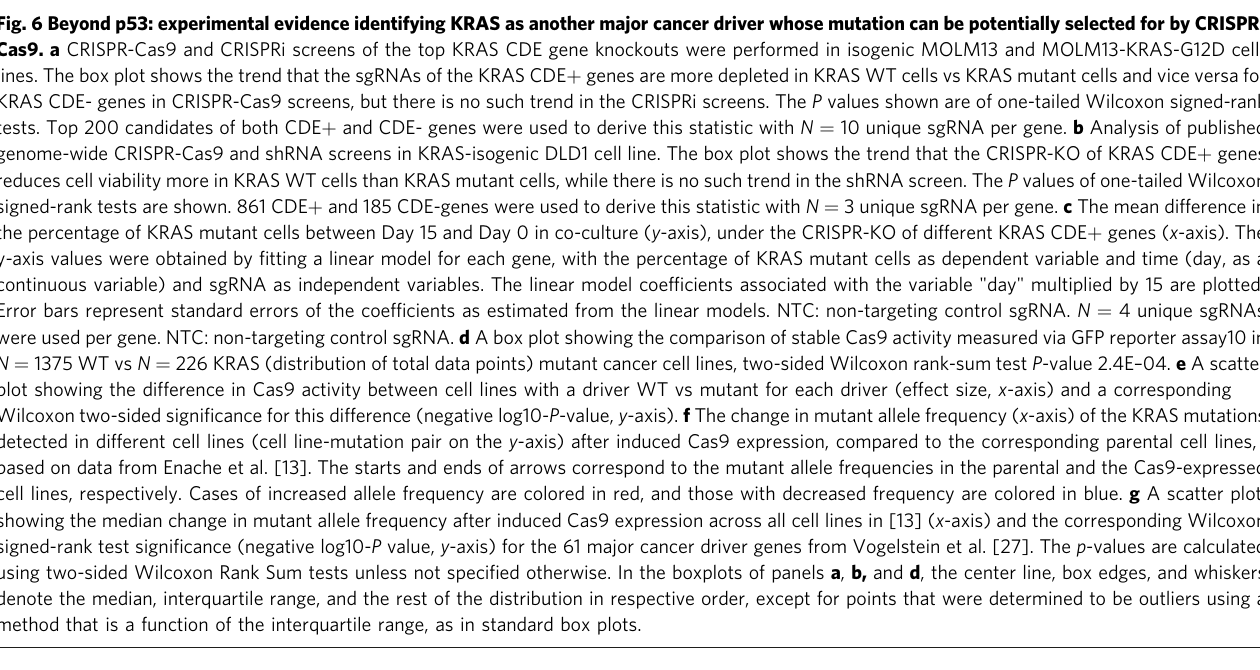
Fig. 6 Beyond p53: experimental evidence identifying KRAS as another major cancer driver whose mutation can be potentially selected for by CRISPR- Cas9. a CRISPR-Cas9 and CRISPRi screens of the top KRAS CDE gene knockouts were performed in isogenic MOLM13 and MOLM13-KRAS-G12D cell lines. The box plot shows the trend that the sgRNAs of the KRAS CDE + genes are more depleted in KRAS WT cells vs KRAS mutant cells and vice versa for KRAS CDE- genes in CRISPR-Cas9 screens, but there is no such trend in the CRISPRi screens. The P values shown are of one-tailed Wilcoxon signed-rank tests. Top 200 candidates of both CDE + and CDE- genes were used to derive this statistic with N = 10 unique sgRNA per gene. b Analysis of published genome-wide CRISPR-Cas9 and shRNA screens in KRAS-isogenic DLD1 cell line. The box plot shows the trend that the CRISPR-KO of KRAS CDE + genes reduces cell viability more in KRAS WT cells than KRAS mutant cells, while there is no such trend in the shRNA screen. The P values of one-tailed Wilcoxon signed-rank tests are shown. 861 CDE + and 185 CDE-genes were used to derive this statistic with N = 3 unique sgRNA per gene. c The mean difference in the percentage of KRAS mutant cells between Day 15 and Day 0 in co-culture ( y -axis), under the CRISPR-KO of different KRAS CDE + genes ( x -axis). The y-axis values were obtained by fi tting a linear model for each gene, with the percentage of KRAS mutant cells as dependent variable and time (day, as a continuous variable) and sgRNA as independent variables. The linear model coef fi cients associated with the variable "day" multiplied by 15 are plotted. Error bars represent standard errors of the coef fi cients as estimated from the linear models. NTC: non-targeting control sgRNA. N = 4 unique sgRNAs were used per gene. NTC: non-targeting control sgRNA. d A box plot showing the comparison of stable Cas9 activity measured via GFP reporter assay10 in N = 1375 WT vs N = 226 KRAS (distribution of total data points) mutant cancer cell lines, two-sided Wilcoxon rank-sum test P -value 2.4E – 04. e A scatter plot showing the difference in Cas9 activity between cell lines with a driver WT vs mutant for each driver (effect size, x -axis) and a corresponding Wilcoxon two-sided signi fi cance for this difference (negative log10- P -value, y -axis). f The change in mutant allele frequency ( x -axis) of the KRAS mutations detected in different cell lines (cell line-mutation pair on the y -axis) after induced Cas9 expression, compared to the corresponding parental cell lines, based on data from Enache et al. [13]. The starts and ends of arrows correspond to the mutant allele frequencies in the parental and the Cas9-expressed cell lines, respectively. Cases of increased allele frequency are colored in red, and those with decreased frequency are colored in blue. g A scatter plot showing the median change in mutant allele frequency after induced Cas9 expression across all cell lines in [13] ( x -axis) and the corresponding Wilcoxon signed-rank test signi fi cance (negative log10- P value, y -axis) for the 61 major cancer driver genes from Vogelstein et al. [27]. The p -values are calculated using two-sided Wilcoxon Rank Sum tests unless not speci fi ed otherwise. In the boxplots of panels a , b, and d , the center line, box edges, and whiskers denote the median, interquartile range, and the rest of the distribution in respective order, except for points that were determined to be outliers using a method that is a function of the interquartile range, as in standard box